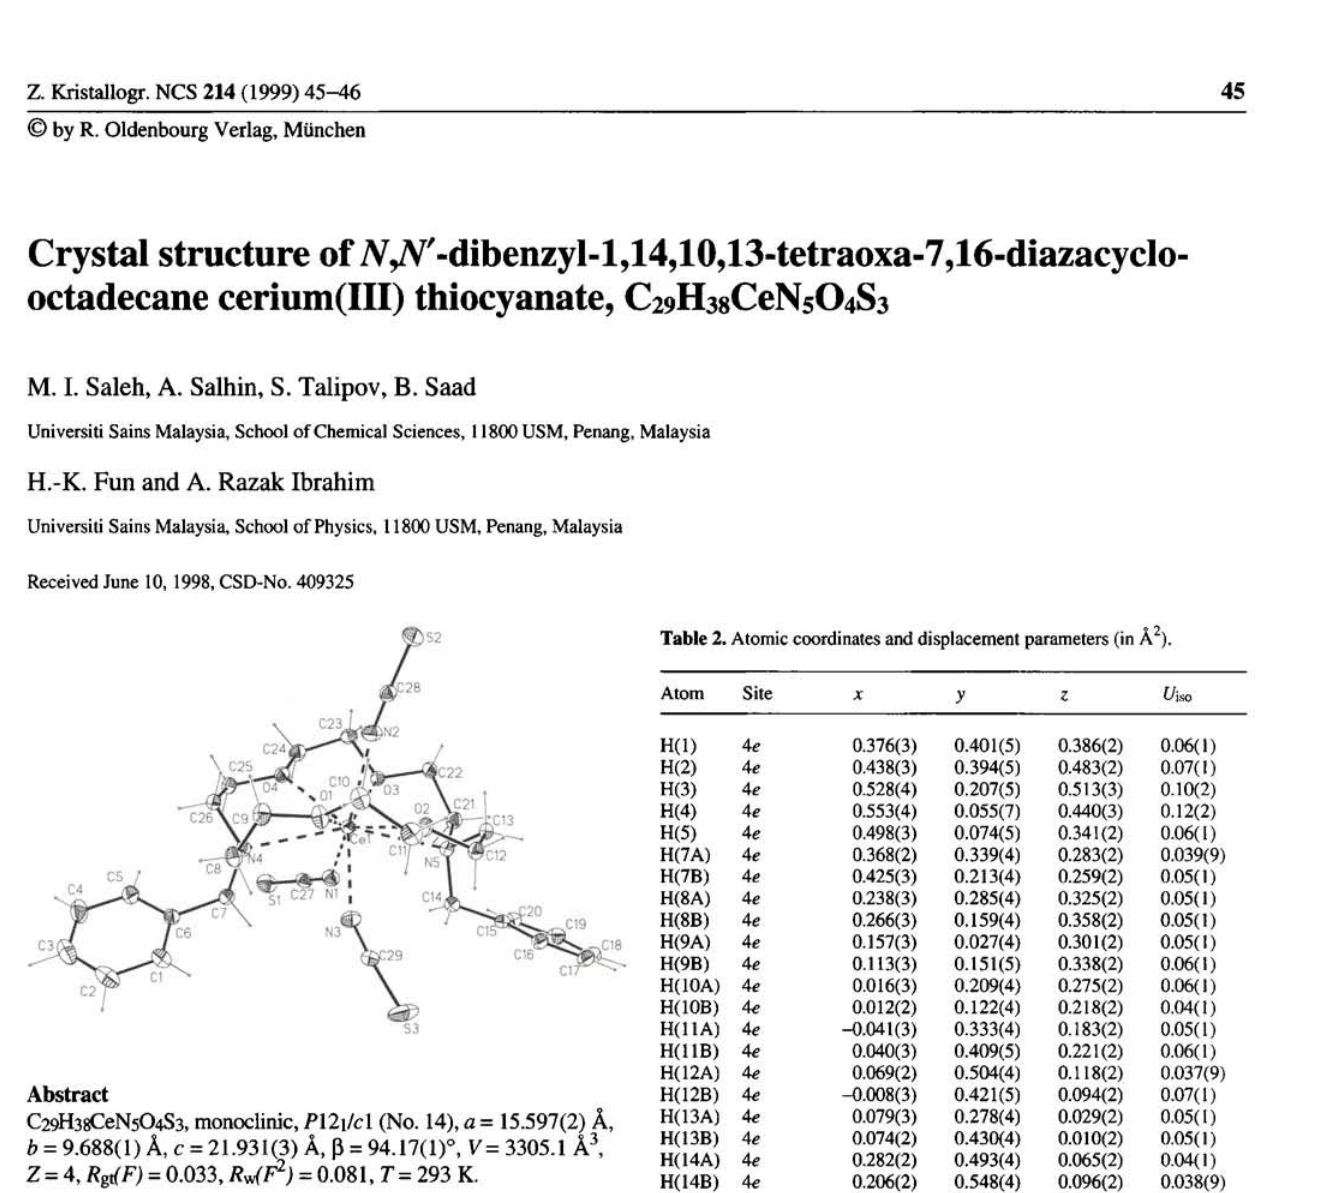
Table 1. Data collection and